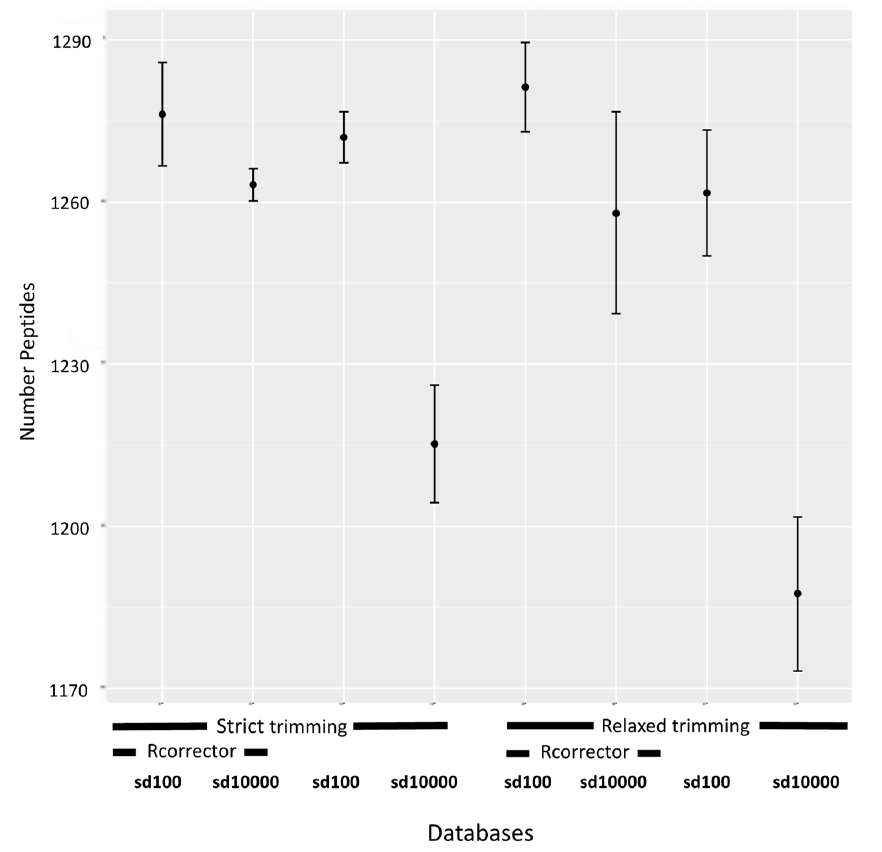
Figure 3. Plot of the mean number of peptides identified across eight transcriptomic databases constructed using different read processing conditions in walnut ( n = 4). Bars represent standard deviations, sd = max_pct_stdev.